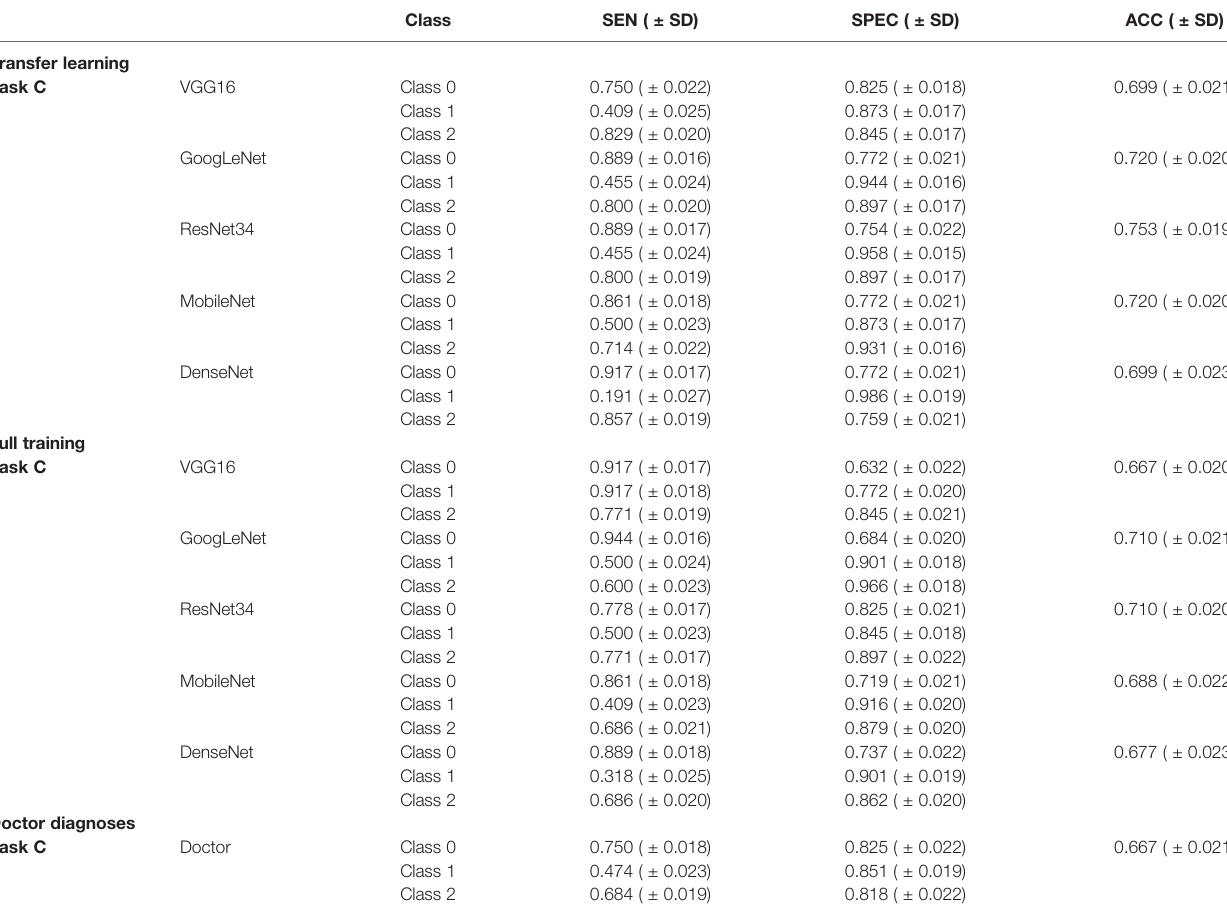
Task C: discriminating benign vs. borderline vs. malignant tumors. Class 0: malignant tumors; Class 1: borderline tumors; Class 2: benign tumors. ACC, accuracy; SEN, sensitivity; SPEC, speci fi city; SD, standard